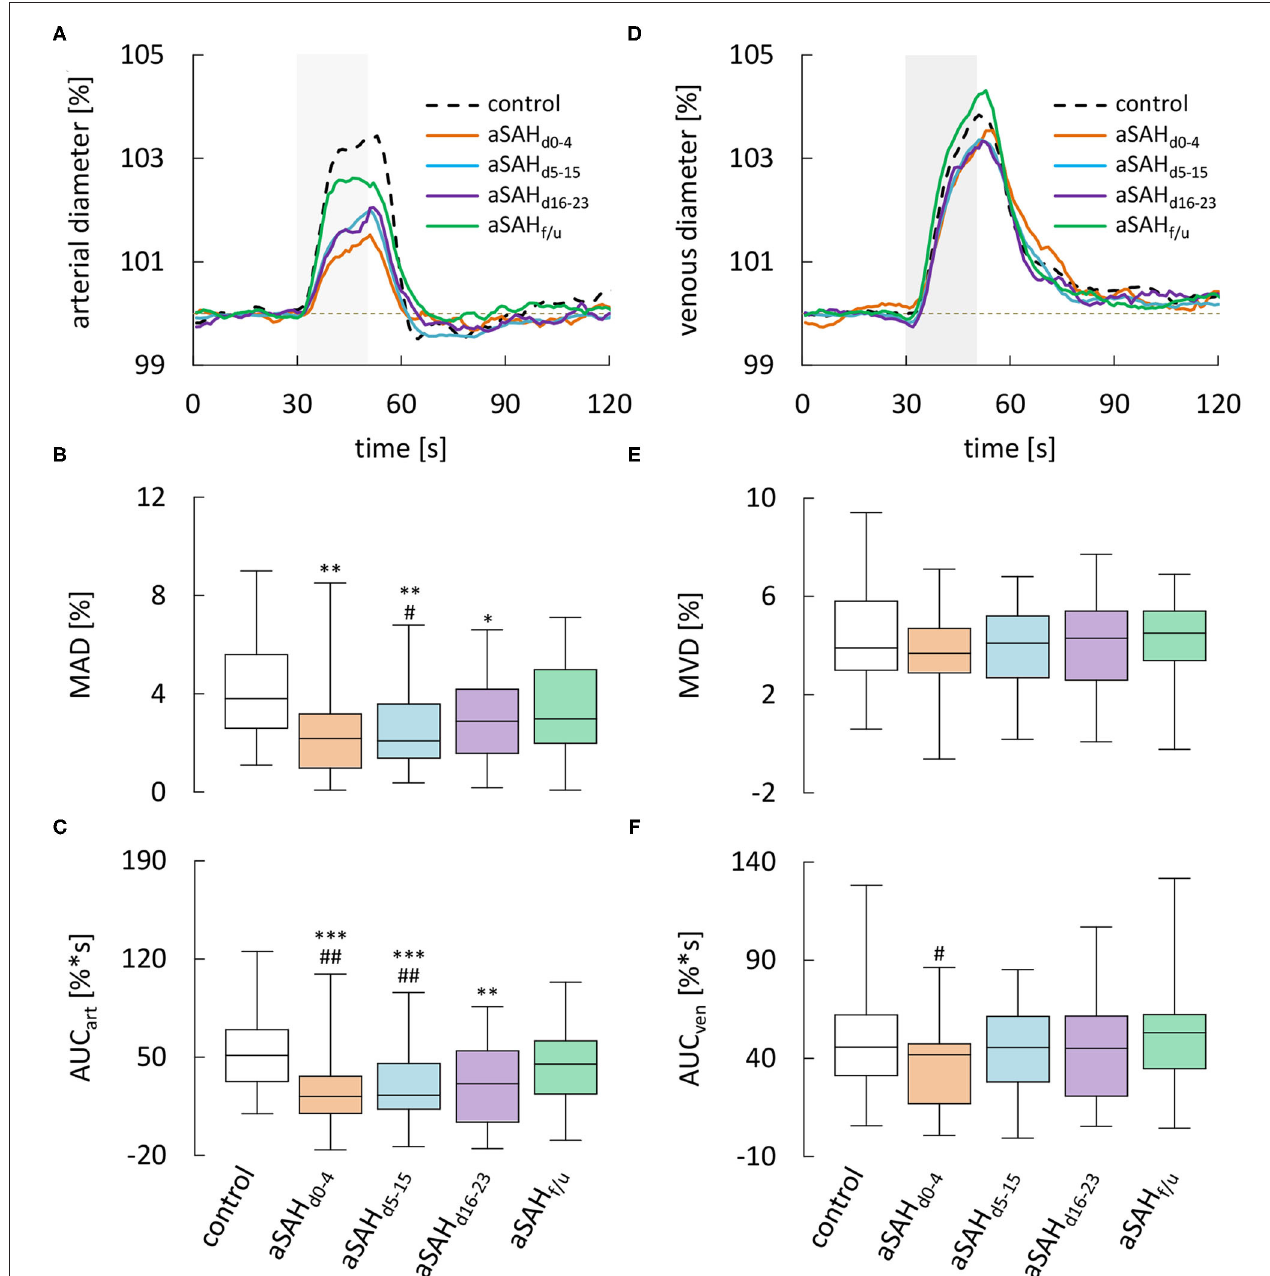
FIGURE 3 | Results from dynamic RVA in aSAH patients and control subjects. (A) Average relative retinal arterial responses to flicker light stimulation measured in control subjects and aSAH patients during the early (aSAH d0 − 4 ), critical (aSAH d5 − 15 ), and late (aSAH d16 − 23 ) phase and at follow-up more than 6 weeks after the ictus (aSAH f / u ). Stimulation period is indicated by light gray shading. (B) Maximum arterial dilation (MAD) quantified from data shown in A. (C) Arterial area under the curve (AUC art ) quantified from the data shown in A. (D) Average retinal venous responses to flicker light stimulation measured in control subjects and aSAH patients at the same times as in A. (E) Maximum venous dilation (MVD) quantified from the data shown in D. (F) Venous area under the curve (AUC ven ) quantified from the data shown in A. *** p < 0.001 vs. control; ** p < 0.01 vs. control; * p = 0.05 vs. control; ## p < 0.01 vs. aSAH f / u ; # p < 0.05 vs. aSAH f / u